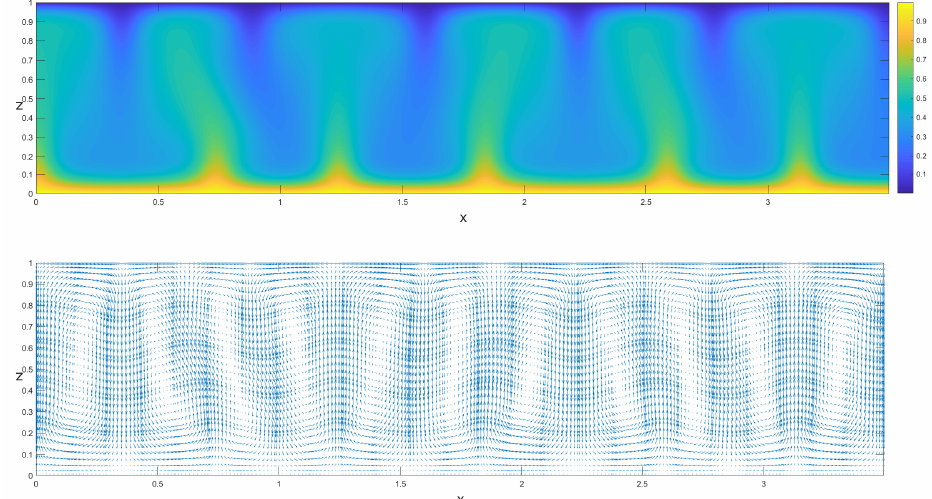
Figure 13. Isotherms and velocity field of a numerical solution obtained with alternating Schwarz domain decomposition; R = 10 5 , Γ = 3.495, np = 25, mp = 5, N × M = 16 × 12.